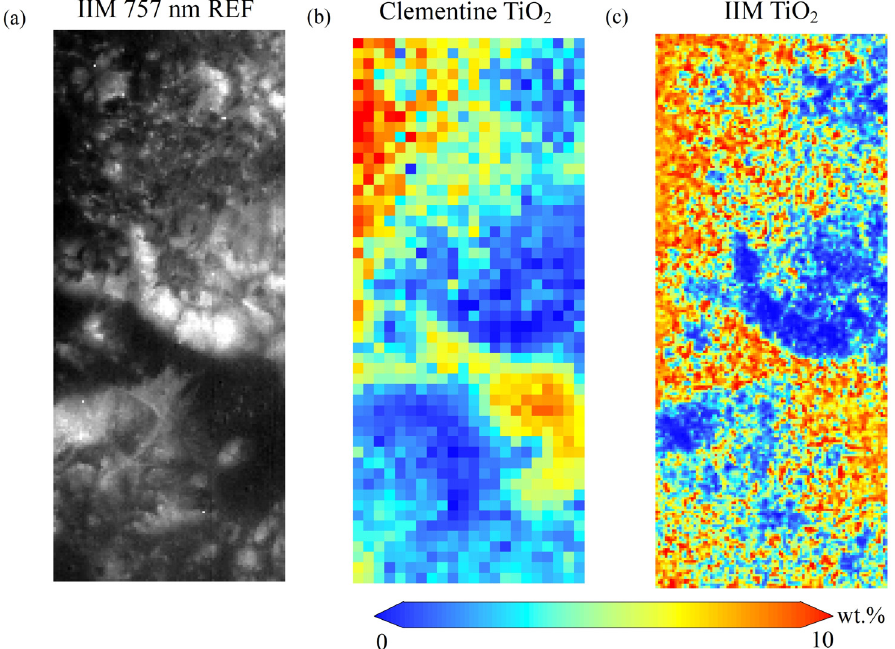
Figure 10. Apollo 17 area: ( a ) IIM 757 nm reflectance image, ( b ) TiO 2 contents from Lucey et al. [17], and ( c ) TiO 2 prediction results of the Extra-Trees model based on feature band selection.